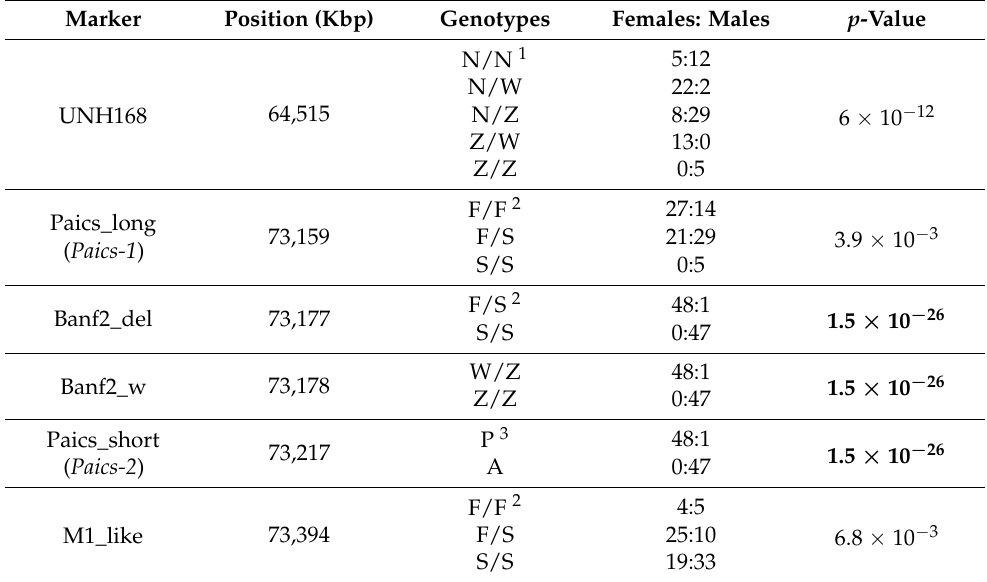
Figure 2. An alignment of the predicted protein domains encoded by the third exons of banf2w (nucleotide accession number: OU016046) and banf2 (nucleotide accession number: OU022051) of Oreochromis aureus ( Oa ), O. tanganicae (Ot , nucleotide accession numbers: OU016126, OU016104) , Pelmatolapia mariae ( Pm , nucleotide accession numbers: OU017683, OU017684) and O. urolepis horno- rum ( Oh , nucleotide accession numbers: OU070172, OU070150) Dashes indicate gaps introduced by the alignment program. Identical amino acid residues in at least three of eight sequences are indicated by a black background. White boxes indicate non-conservative amino acid changes between the proteins. Table 3. Markers and their association with sex in Oreochromis aureus hybrid stock ( n =